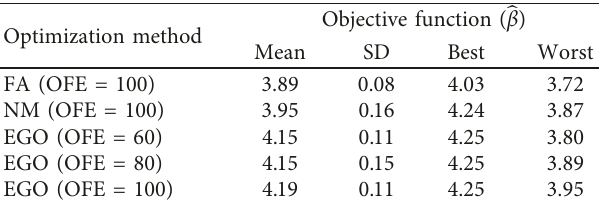
Figure 2: Setting the value of n Table 2: 2-FTMD system (Case 1): results for different optimi- zation methods over 10 independent runs.